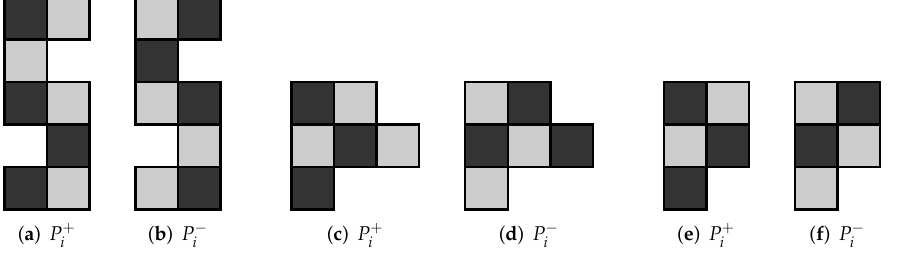
= P − with p i = 0; ( c , d ) P + i i